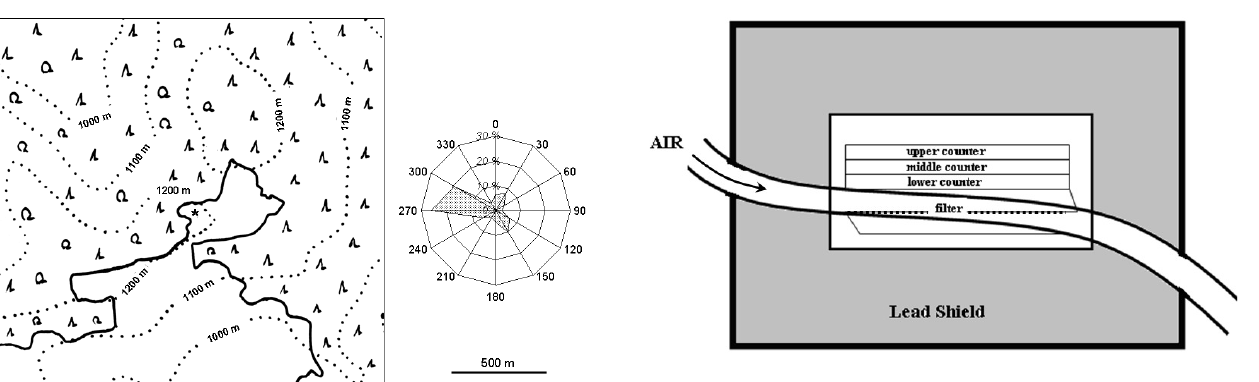
Figure 2: The One-filter detector system contains a membrane filter and a stack of three independent, methane-filled, proportional counters having the same length and width as the active filter area. The middle counter detects the high energy α -activity of 212 Po ( 220 Rn progeny). Activity of 212 Po, together with the change in 212 Po activity over time, are used to determine total 220 Rn progeny contribution to total counts in the lower counter. By difference, the 222 Rn progeny activity is derived from the lower counter. The upper counter counts ß particles only (redrawn from Stockburger & Sitttkus, 1966).